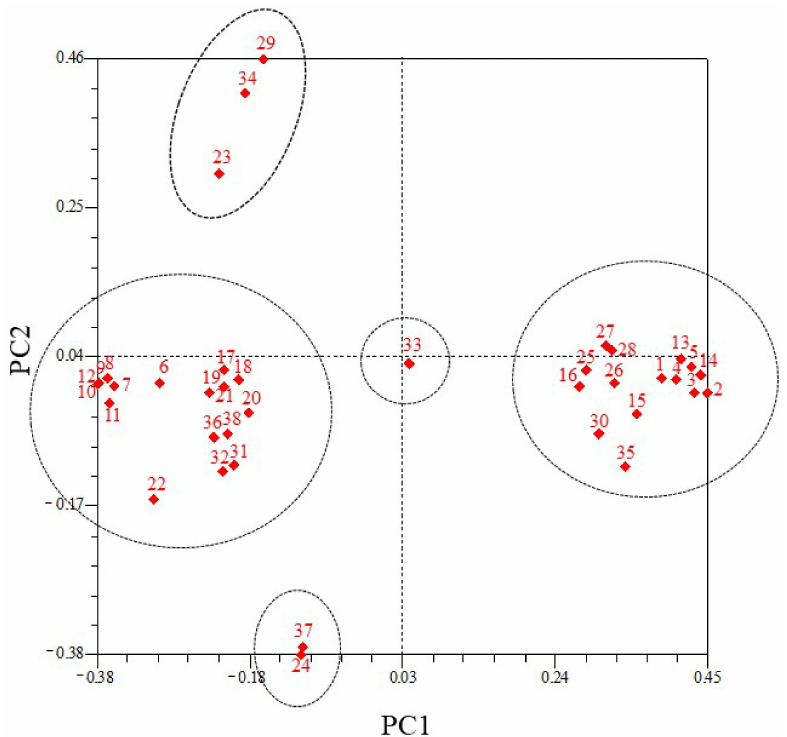
Figure 3. PCoA analysis of 38 Pennisetum materials. The numbers on the horizontal and vertical coordinates in the figure represent the genetic coefficient, and the numbers represent the sample numbers from 1 to